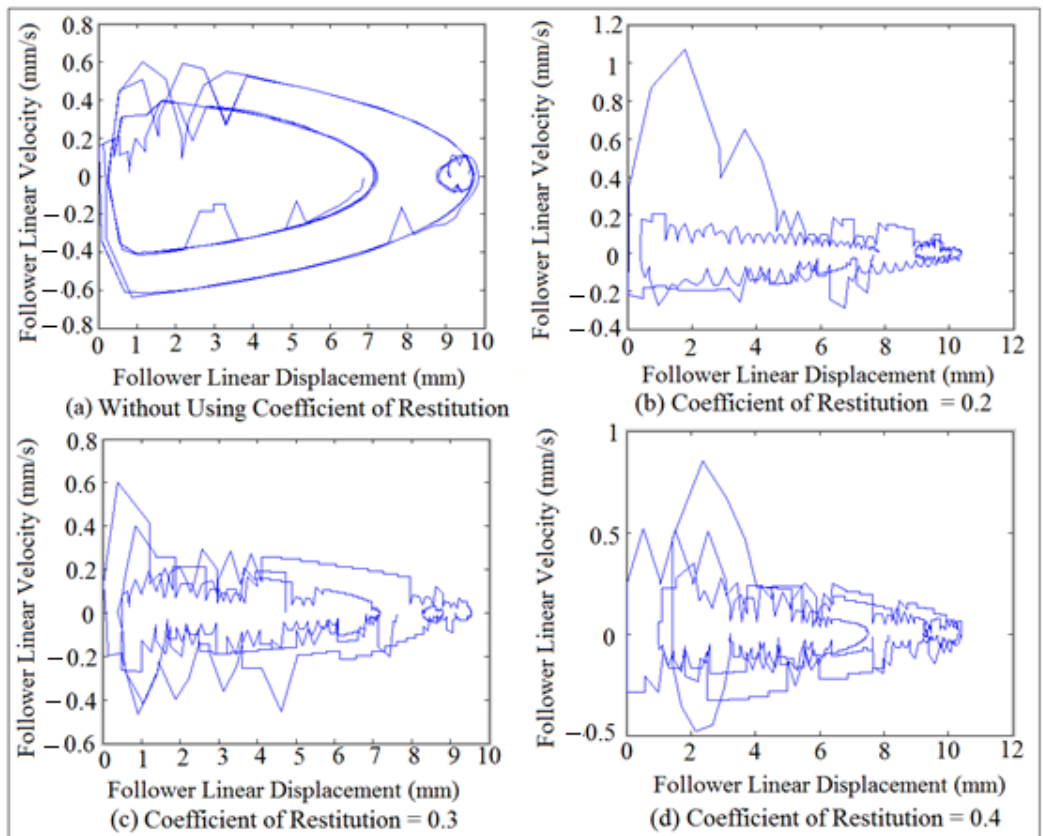
Figure 28. Phase-plane diagram mapping using different values of coefficient of restitution.